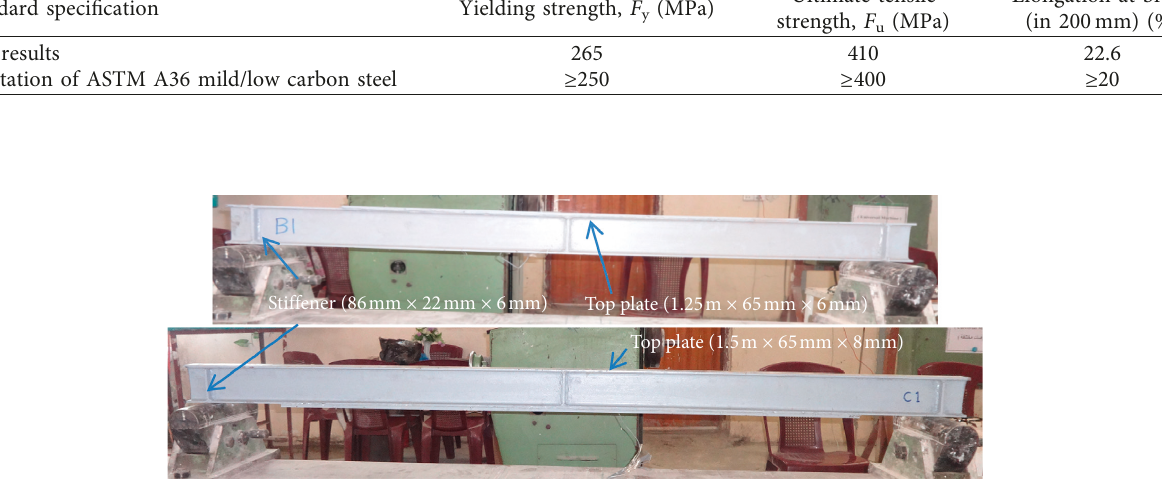
Figure 2: Details of the cover plate and stiffeners on a tested steel beam.